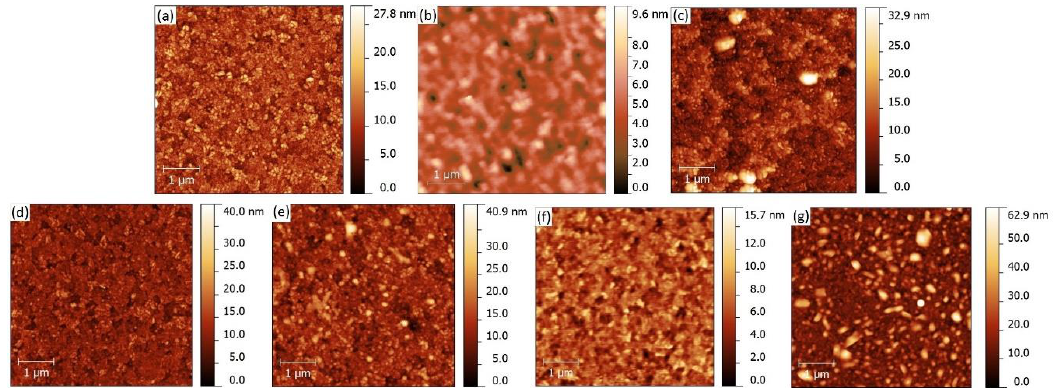
Figure 8. Height images of ( a ) Indium-tin oxide (ITO) substrate and ITO substrates with 1 or 5 monolayers of nitrothiacalix[4]arenes; ( b ) 1 ; ( c ) 2b ; ( d , e ) 3 ; ( f , g ) 8 (AFM, tapping mode, 5 μm × 5 μm). Table 4. Morphological characteristics of Langmuir films of chromophoric thiacalixarenes 1 , 2b , 3 , 8 on ITO (data are given for 1 monolayer and (in parentheses) 5 monolayers). Compound Roughness R q , nm Thickness h , nm